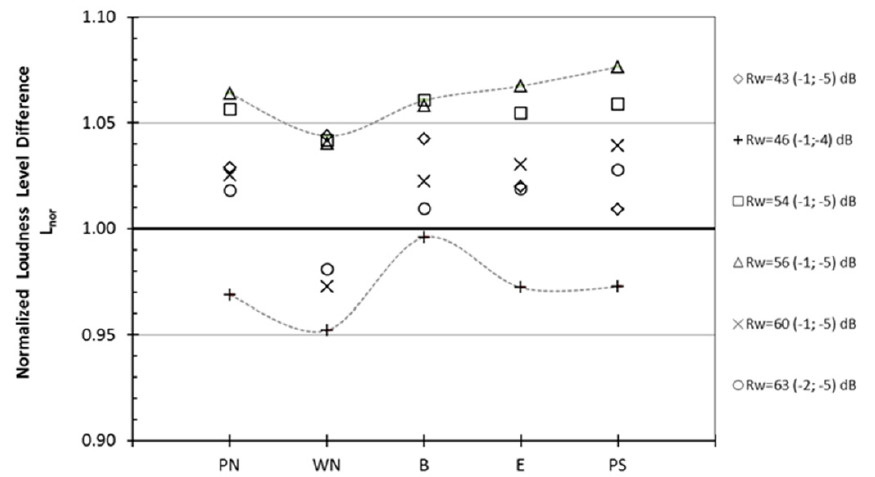
Figure 4. Normalized loudness level difference ( L nor ) for different sound samples calculated for a single wall construction of sand-lime brick of thickness ranging from 70 to 300 mm and calculated sound reduction index R w ( C ; C tr ). The upper and lower dotted grey lines indicate the region for the individual results. PN stands for pink noise, WN for white noise, B for Beethoven, E for Eminem, and PS for Party Sound.